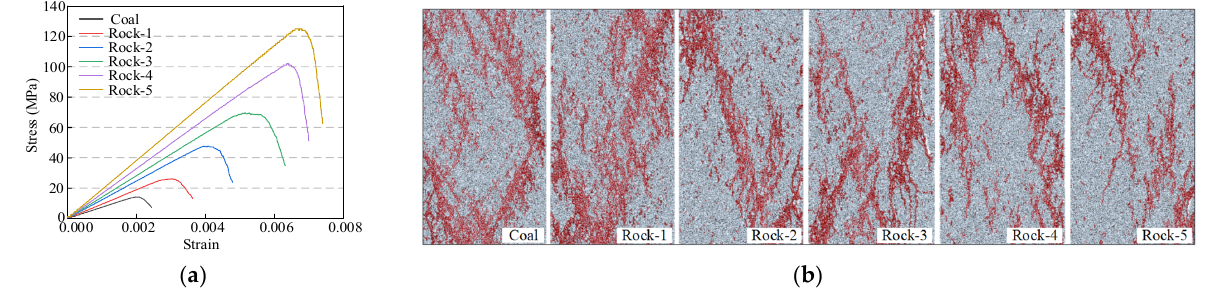
Figure 2. Calibration model for stress–strain curves and failure pattern. ( a ) Stress–strain curves. ( b ) Failure pattern.